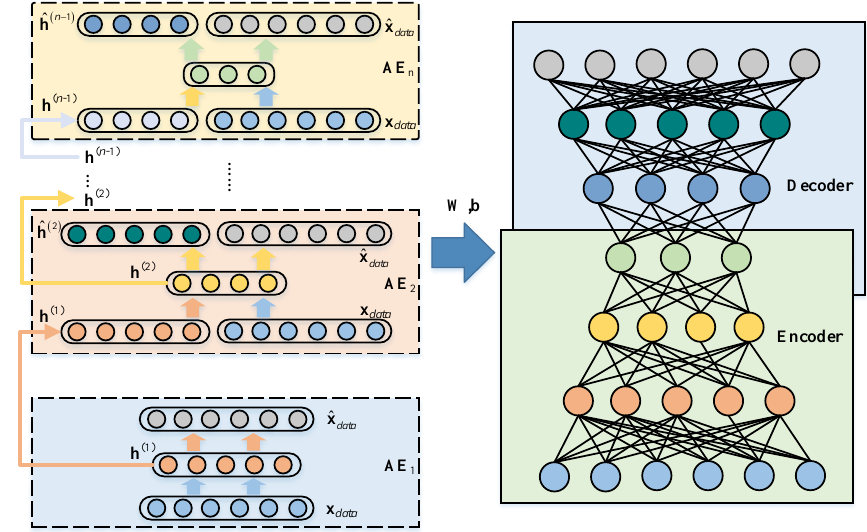
Figure 2. ESAE Network Structure